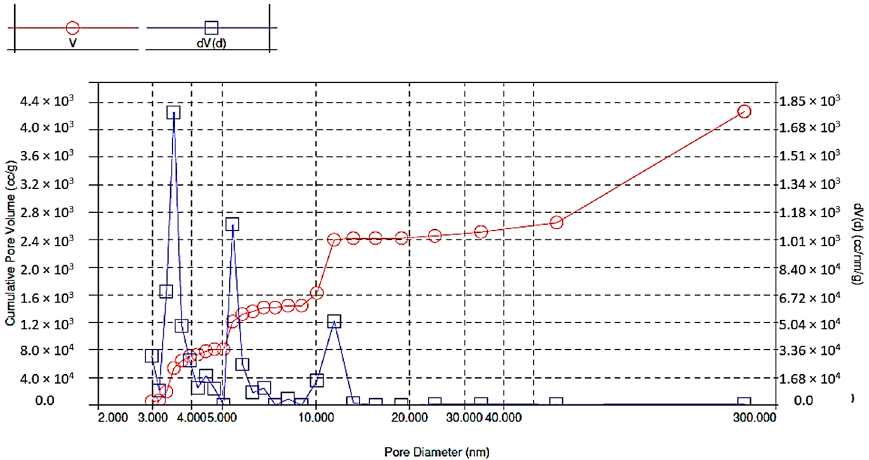
Figure 5. Pore size distribution in brewer’s grains during adsorption.